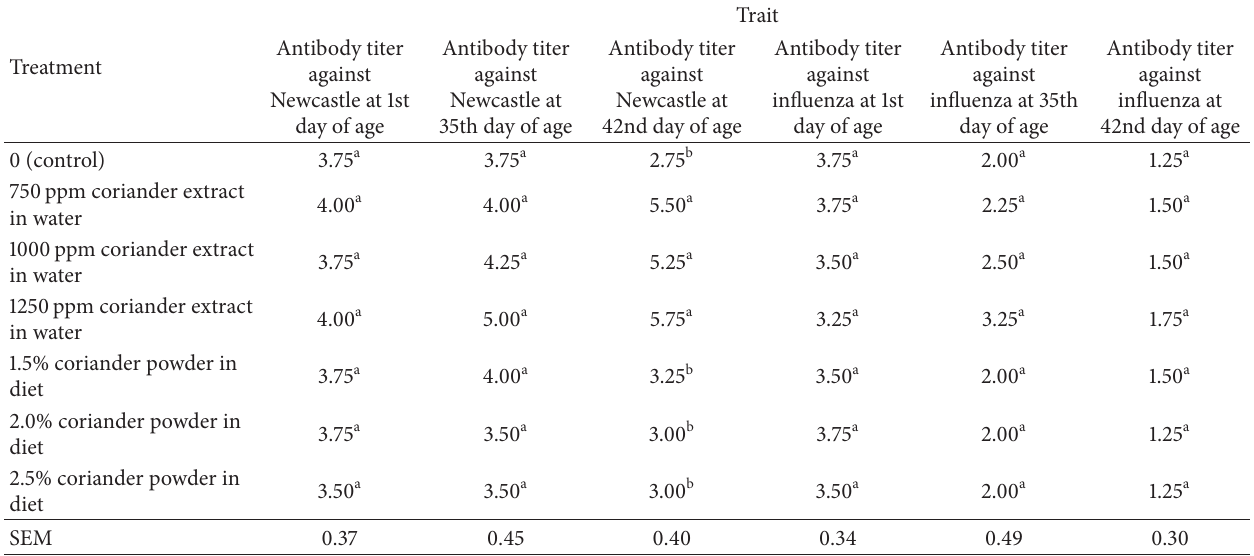
Table 9: Immunological responses against Newcastle (ND) and avian influenza (AI) mean ( ± SEM) of Ross 308 broilers fed diets or water containing the different levels of coriander ( Coriandrum sativum L.) powder and extract from 1 to 6 weeks of age (log 2 ) a,b .